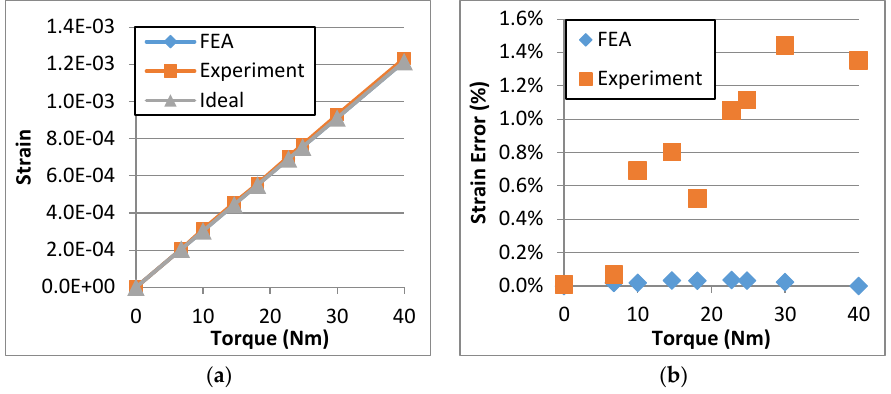
Figure 14. Relationship of the strain vs torque. ( a ) strain; ( b ) strain error. Table 4. Comparison experiment result with FEA.